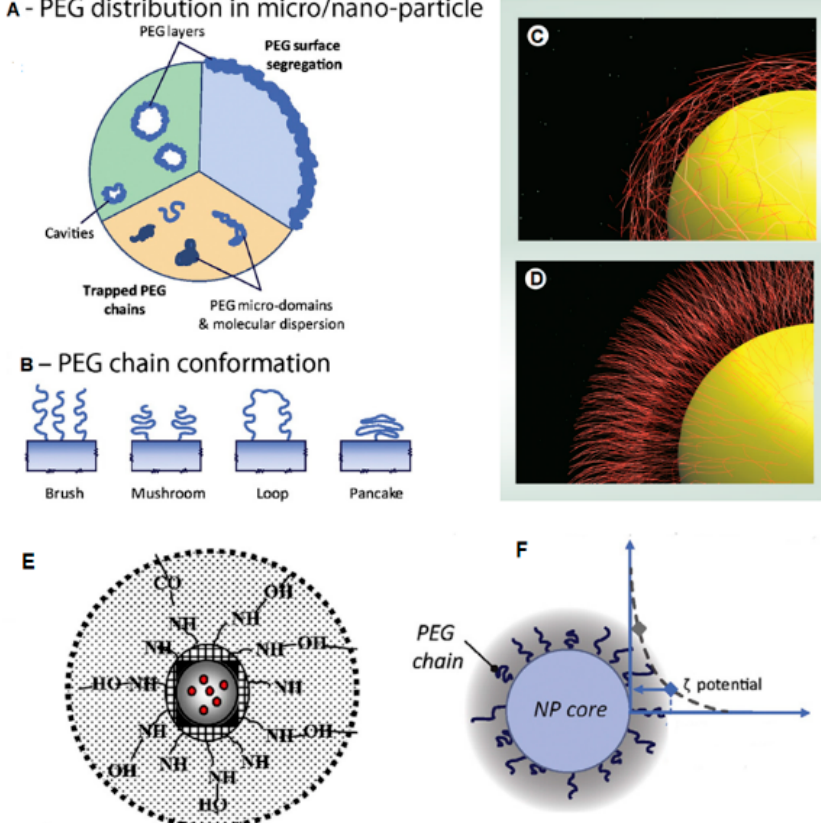
Figure 1. ( A ) Image representing different arrangements of PEG molecules in a nanoparticle. Adapted with permission from [12]. ( B ) Different conformations on nanoparticle surface. Representations of the mushroom ( C ) and brush ( D ) conformations, showing surface densities, reproduced from [11] with permission from Nanomedicine as agreed by Future Medicine Ltd. ( E ) schematic representation of the PLGA-chitosan-PEG nanoparticles prepared in this study. Reproduced with permission from [13]. ( F ) Nanoparticle surface showing detection of surface charge and PEG chains in both mushroom and brush conformations. Adapted with permission from [12].